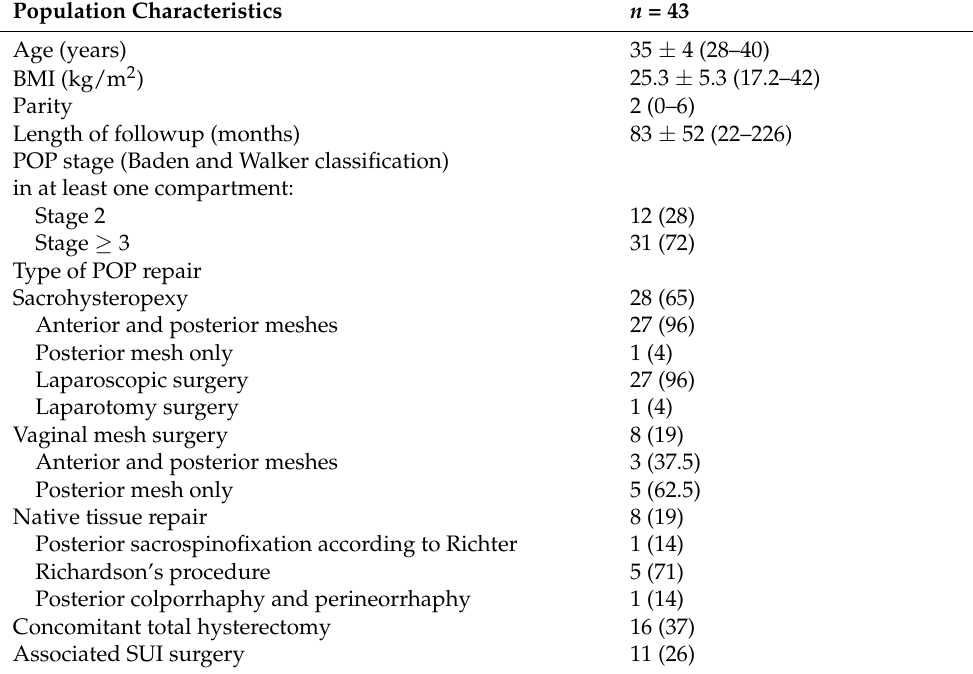
Figure 2. Long-term POP recurrence after a POP repair in women under 40 years old according to the surgical technique. POP: pelvic organ prolapse; VMS: vaginal mesh surgery; NTR: native tissue repair by vaginal route.